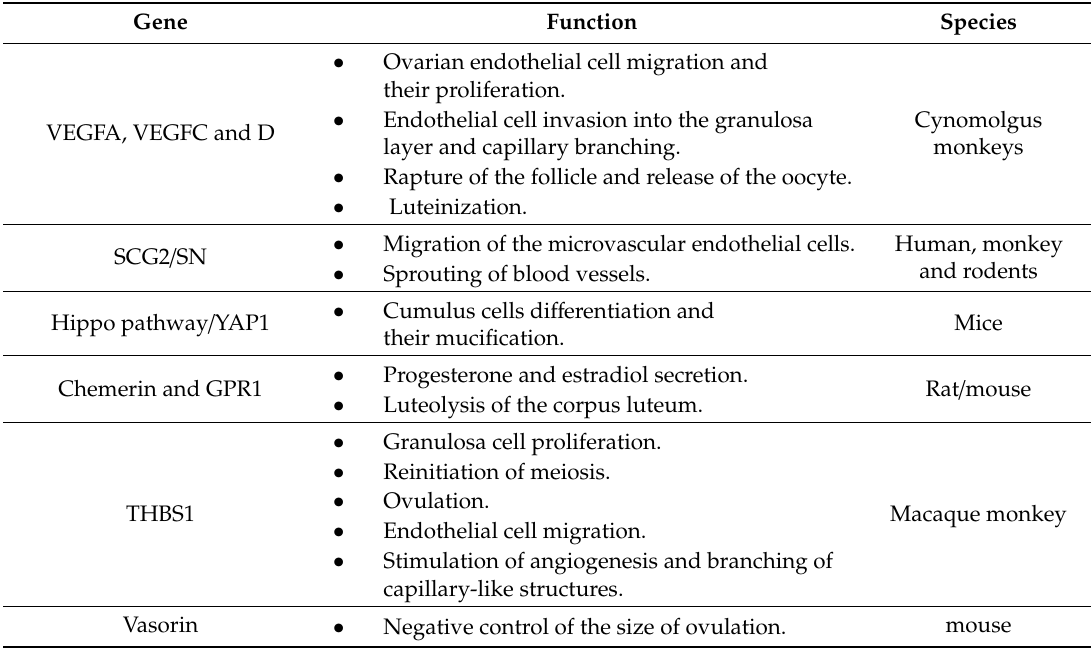
Table 2. Newly identified regulators of